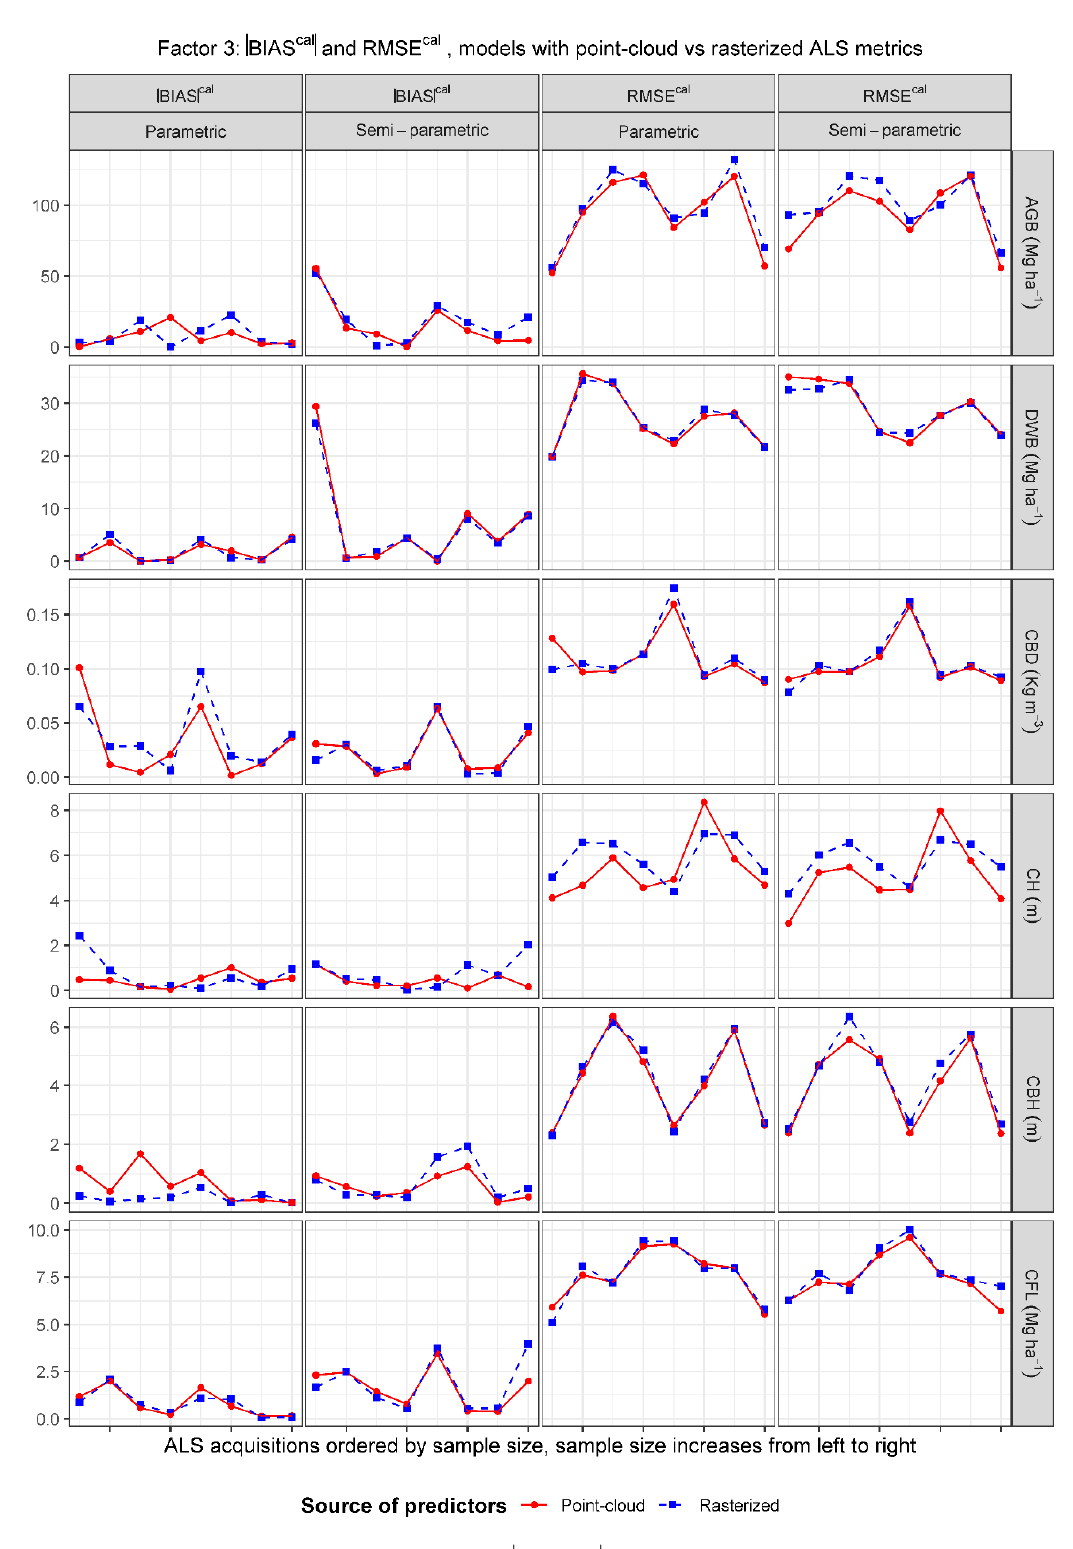
Figure 7. ALS-acquisition-specific values of absolute bias, (cid:3627)(cid:1828)(cid:1835)(cid:1827)(cid:1845) (cid:3030)(cid:3028)(cid:3039) (cid:3627) , and root mean squared error, (cid:1844)(cid:1839)(cid:1845)(cid:1831) (cid:3030)(cid:3028)(cid:3039) , for calibrated predictions for different sources ALS predictors by modeling techniques. AGB, DWB, CBD, CH, CBH, and CFL respectively indicate aboveground biomass, downed woody biomass, canopy bulk density, canopy height, canopy base height, and canopy fuel load.